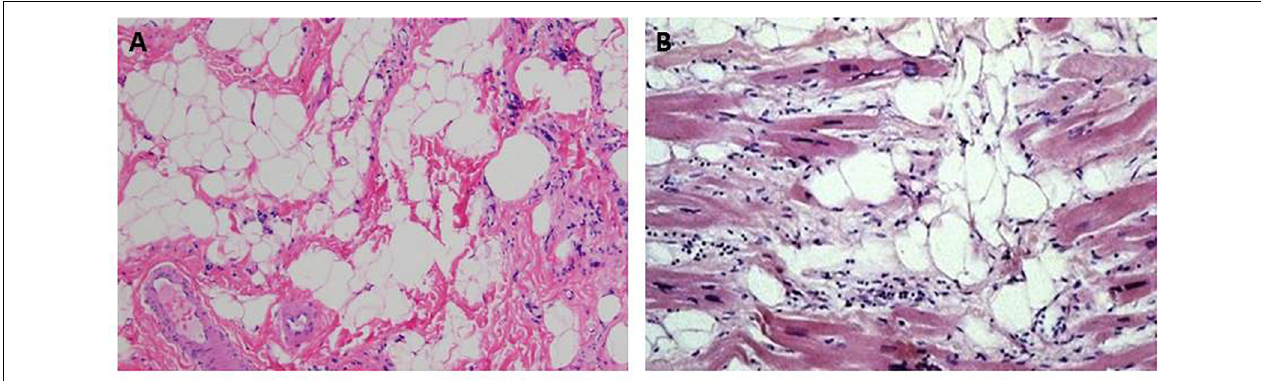
FIGURE 1 | Hematoxylin & eosin images showing fibroadiposis in human skeletal muscle dystrophies (SMD) and in arrhythmogenic cardiomyopathy (ACM). (A) The pathological aspect of the skeletal muscle observed in Duchenne muscle dystrophy. (B) shows the typical histological aspect of the heart tissue in ACM. Panel (A) from Hiser (2020). Panel (B) from Thiene et al.